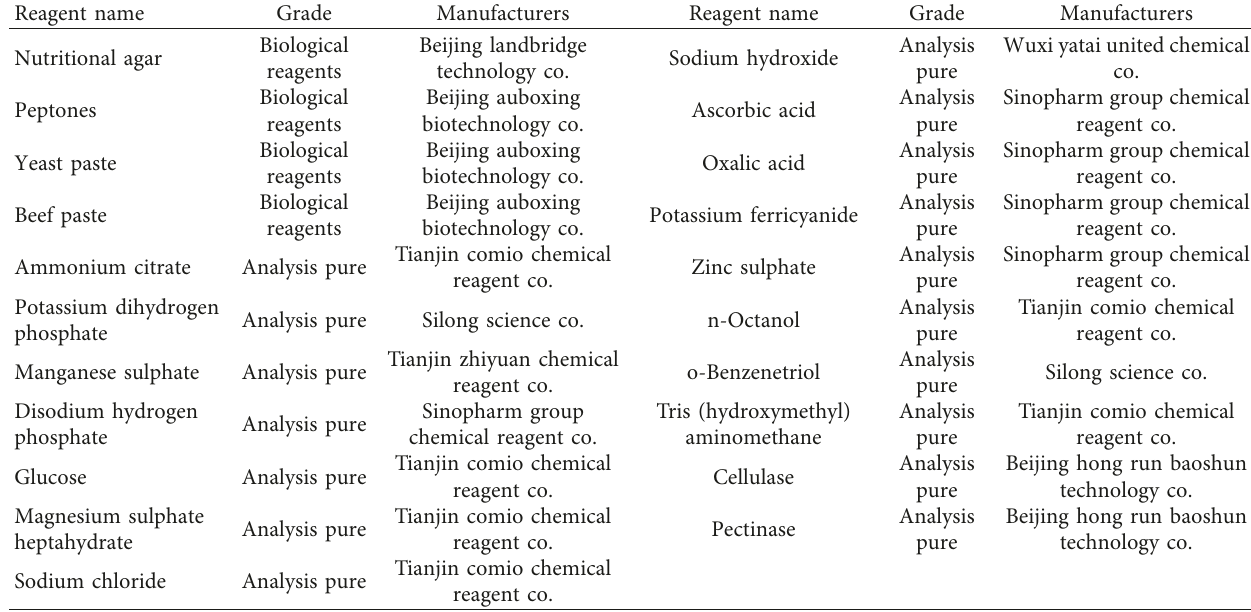
Table 1: Experimental reagents.